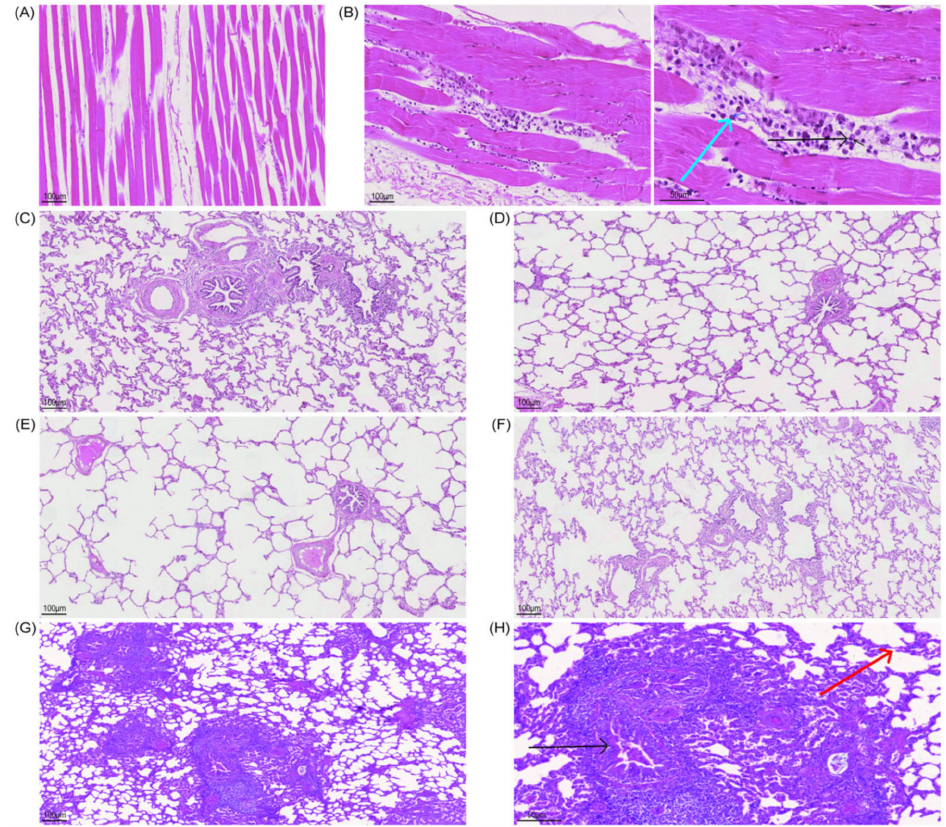
Figure 6. Histopathology of calf lung slices. ( A ) Neck muscles in the blank control group (10 × 10). ( B ) Neck muscles in the immunization group; blue arrows showing macrophages, black arrows showing plasma cells (10 × 10). ( C ) BoHV − 1 immunization group (10 × 10). ( D ) BoHV − 1 ∆ gE immunization group (10 × 10). ( E ) BoHV − 1 gE/E2 − Linker − E2 + immunization group (10 × 10). ( F ) Representative slices of normal lung tissue in the blank control group (10 × 10). ( G ) (10 × 10) and ( H ) (10 × 20) show representative slices of lesion tissue in the challenge control group, and black arrows show bronchi that were compressed and bulging, with bronchospasm and contraction; black arrows show peripheral lymphocytes and monocyte infiltration along with peribronchitis or tubular formations; red arrows show narrowing of alveolar septum and